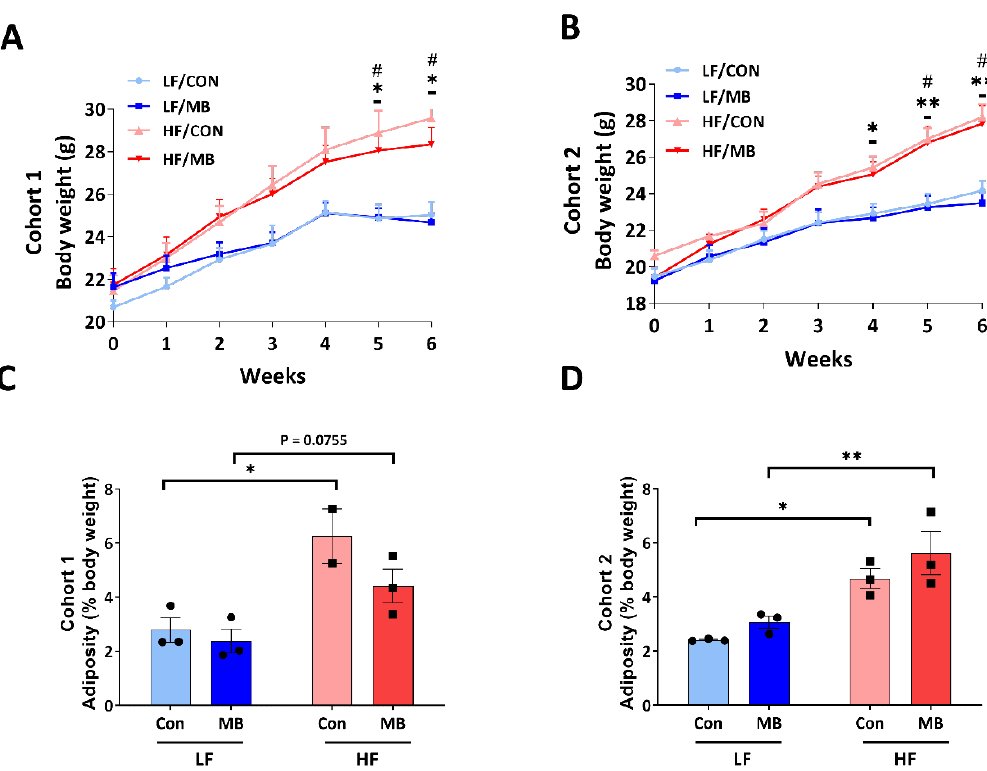
Figure 1. E ff ect of monobutyrin (MB) supplementation on body weight ( A , B ) and adiposity ( C , D ) in low-fat (LF) and high-fat (HF) fed mice. Cohort 1 ( A , C ) and cohort 2 ( B , D ) of mice fed an LF or HF diet with or without 0.25% MB supplementation diet for 6 weeks. Two-way analysis of variance (ANOVA) followed by Tukey’s or Sidak’s post hoc test was used to determine di ff erences among groups. Repeated measures ANOVA was performed for body weight on variable clusters with a random subject e ff ect, whereas variable cluster members, diet, and MB treatment were used as fixed e ff ects. Values are means ± standard of error of mean (SEM)s; n = 6 for body weight (gain) and 2–3 for adiposity / group / cohort. Significant di ff erences are denoted as an asterisk (*) for LF / CON vs. HF / CON at * p < 0.05 and ** p < 0.01 and a sharp ( # ) for LF / MB vs. HF / MB. CON, control; HF, high-fat; HF / CON, HF without MB; HF / MB, HF with 0.25% MB ( w / v ) in drinking water; LF, low-fat; LF / CON, LF without MB; LF / MB, LF with 0.25% MB ( w / v ) in drinking water; MB, monobutyrin.